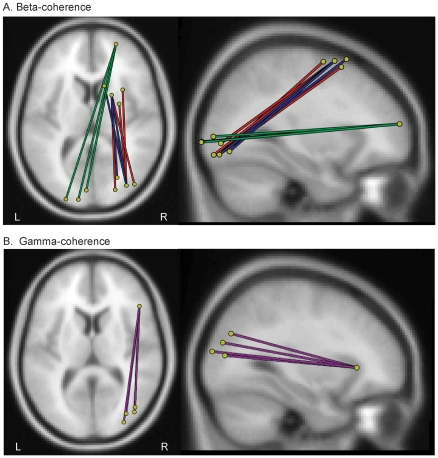
Functional connections showing changes in coherence as a function of concurrent working memory load during visual perception.Spatial pairwise clustering (SPC) was used to identify functional connections in which coherence was modulated as a function of concurrent working memory load during a grid perception task. Beta-connections (18–24 Hz) are displayed in red, blue and green (panel A) and the gamma-connection (30–40 Hz) displayed in purple (panel B). All connections satisfy p<0.05, familywise error (FWE) corrected.